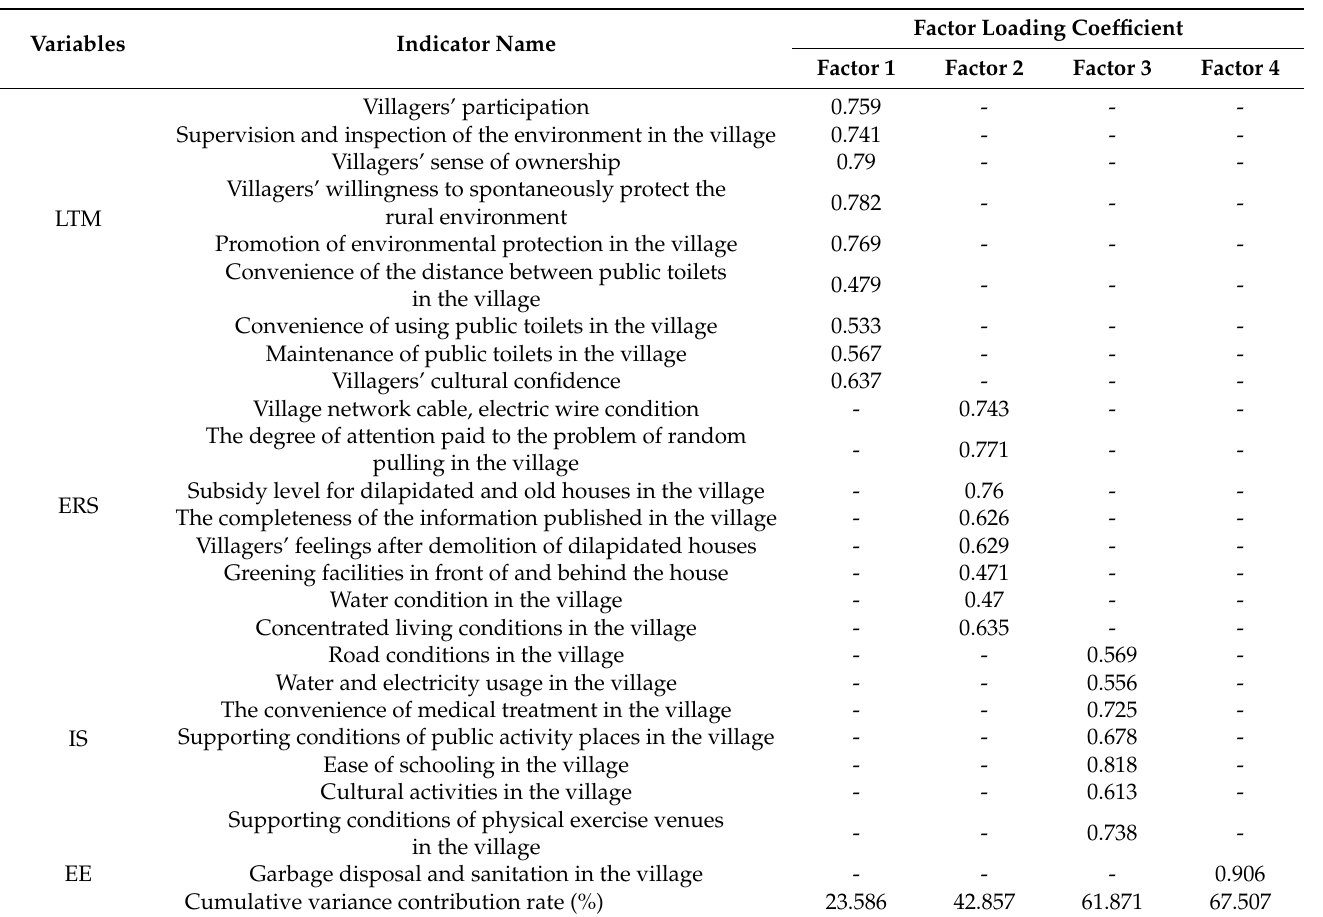
Table 3. Factor loading factors after